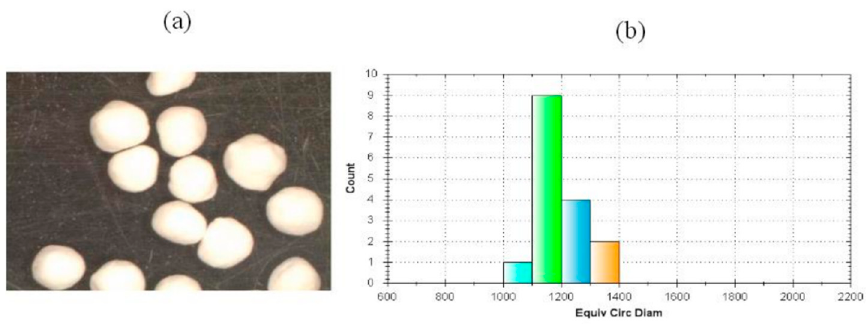
Figure 5. ( a ) Image of self-emulsified pellets from stereoscope and ( b ) corresponding pellet Figure 5. (a) Image of self-emulsified pellets from stereoscope and (b) corresponding pellet size size distribution. distribution.